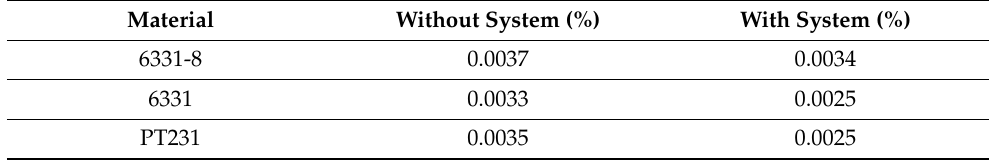
Table 8. Standard deviation of product